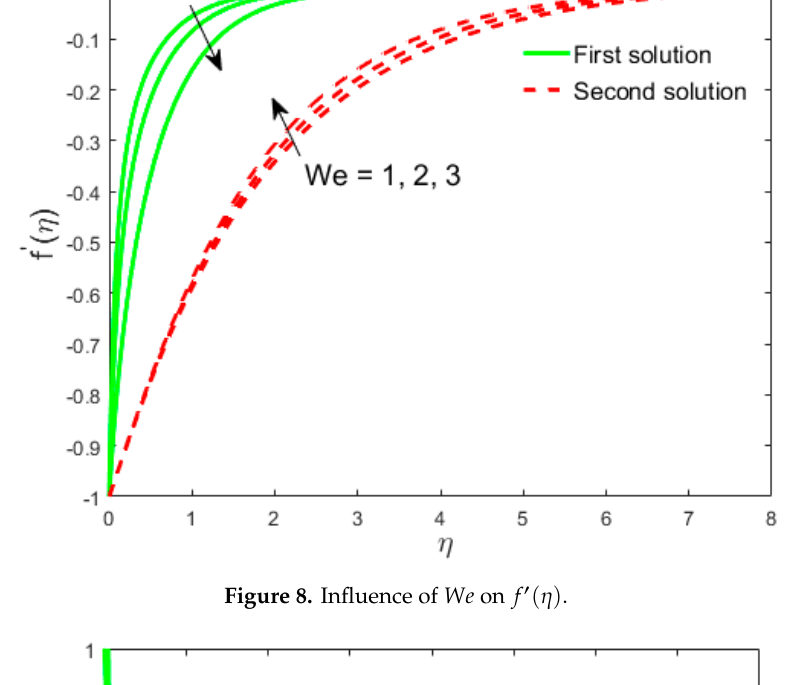
Figure 8. Influence of We on f (cid:48) ( η ) .